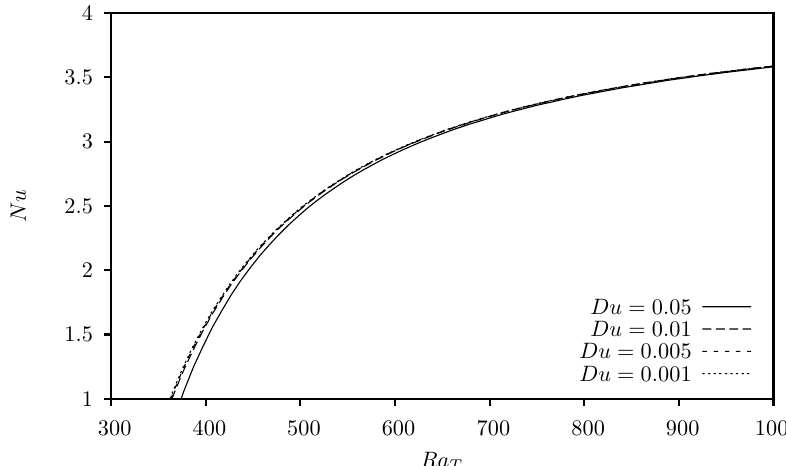
Figure 9. Variation of Nu with Ra T for steady nonlinear stability: effect of Du for Ra s = 250, Ri = 1, Sr = 0.005, Le =